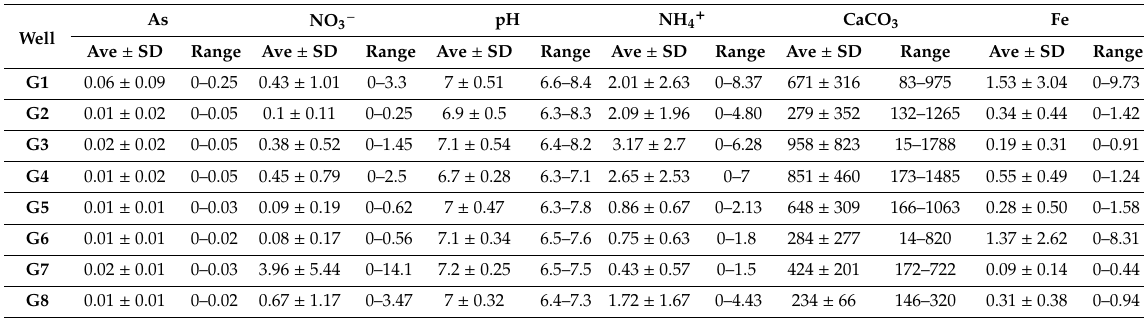
Table A1. Statistical summary of physico-chemical parameters for groundwater samples in the dry